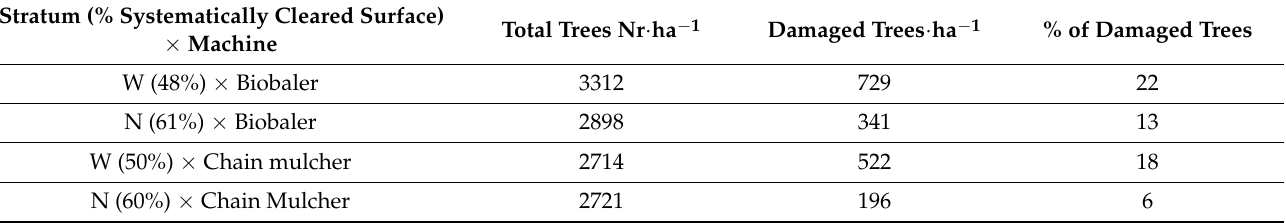
Table 8. Damage to remaining trees and final tree density. Acronyms: N, narrow; W, wide; nr, number; ha, hectare. Stratum (% Systematically Cleared